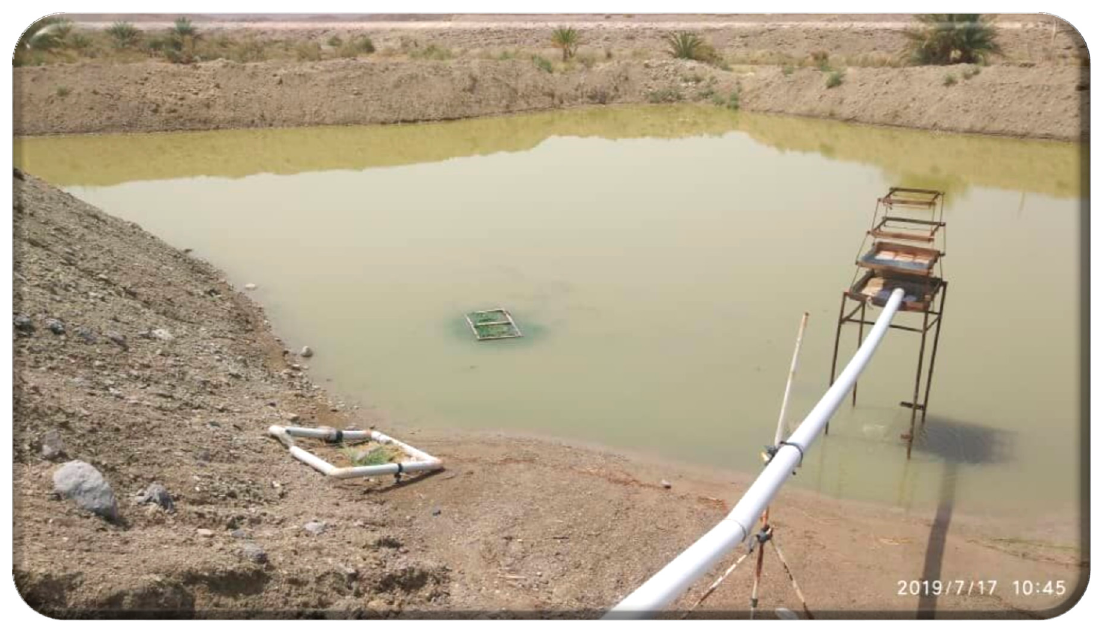
Figure 2. Example of traditional fish breeding pond in Markazi province. Photography taken by Amir H. Aghmashhadi on 17 July 2019.